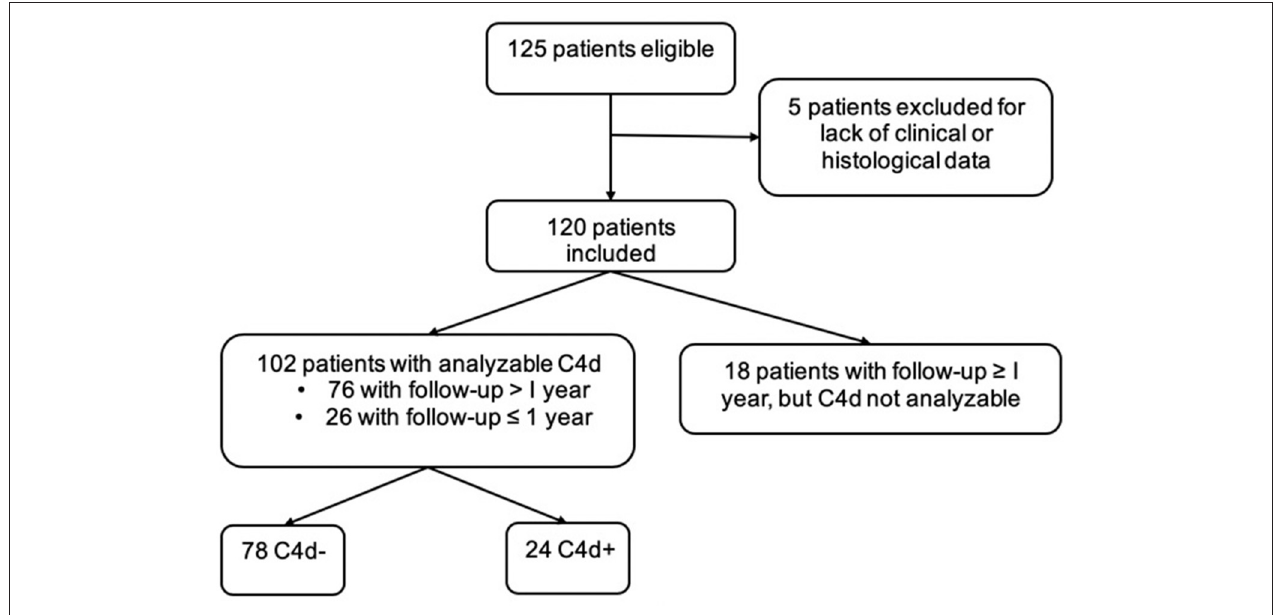
FIGURE 1 | Patient